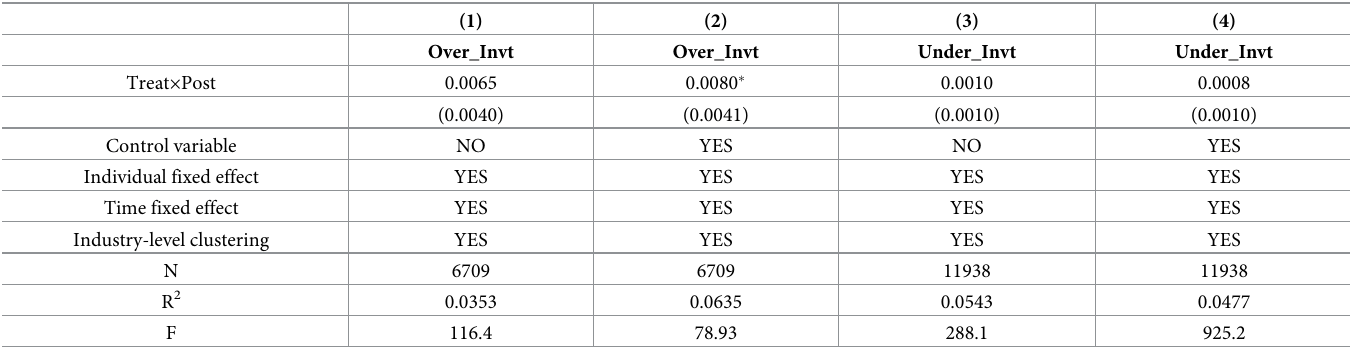
Table 4. Test results of over-investment and